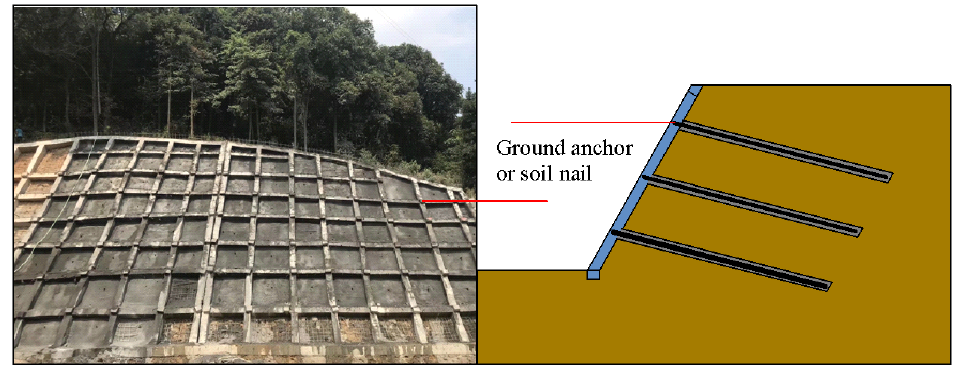
Figure 1. A typical application of the lattice beam retaining structure with anchors on the cutting